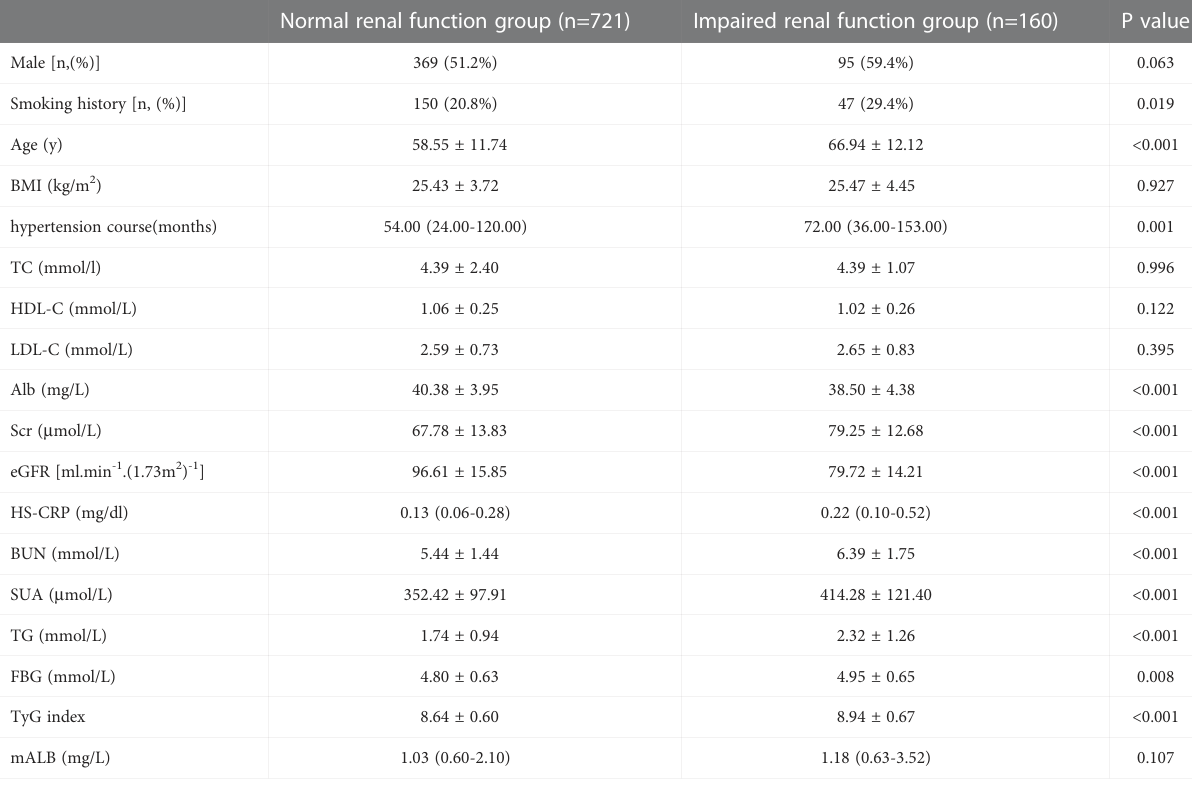
TABLE 4 Comparison of general data and clinical index between two groups on the CysC level.